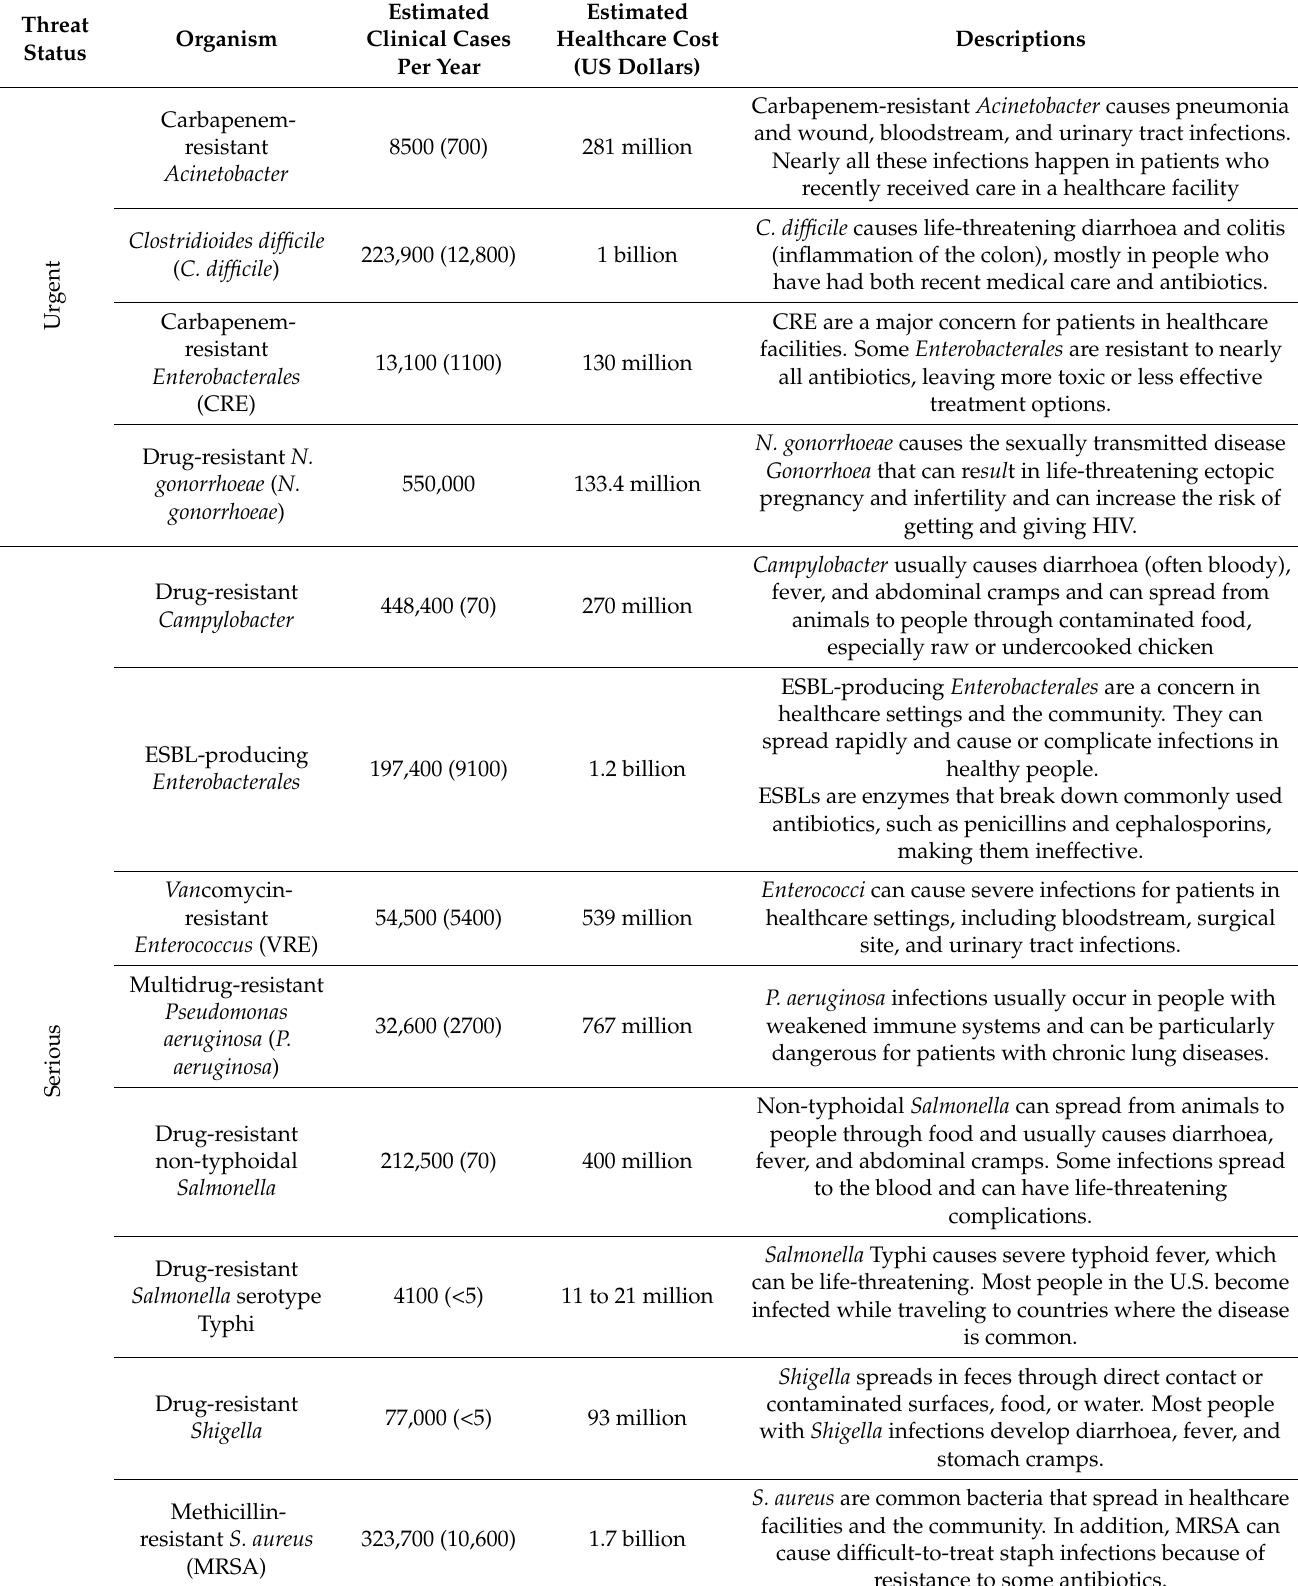
Table 4. Public threat status of different antimicrobial-resistant